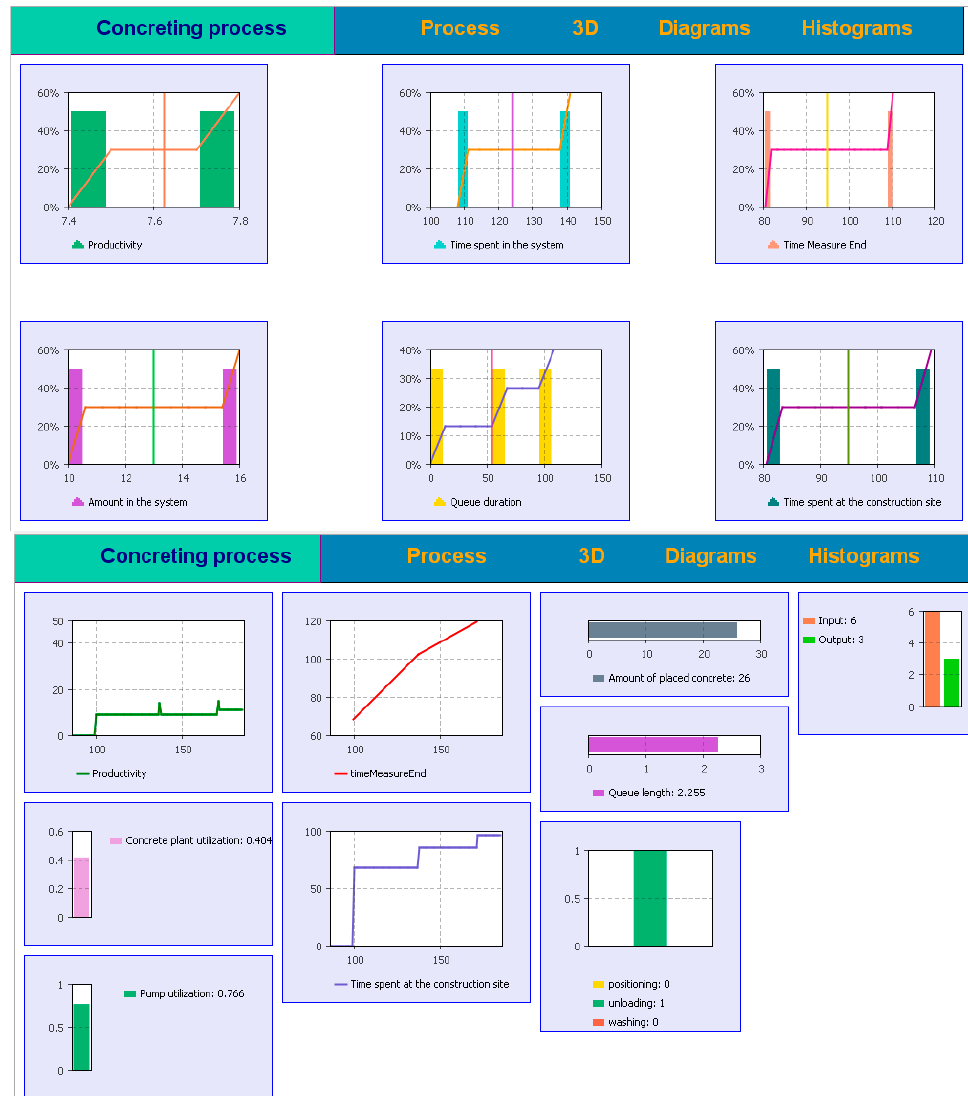
Figure 5. Changes in the state of the system during simulation.